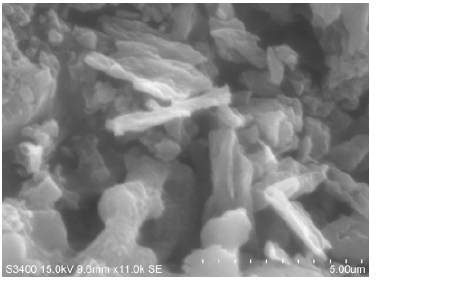
flow at a heating rate of 20 0 C per